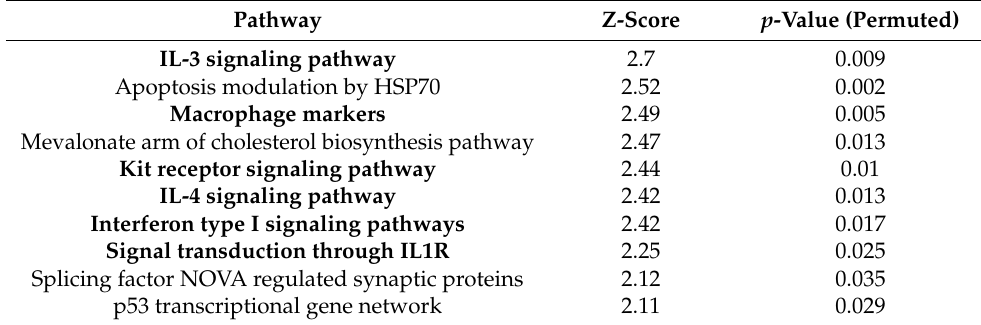
Supplementary Table S2. Cut-off values, i.e., adjusted p -values, for DEG selection using moderated t -tests are indicated. No pathway analysis was conducted for RIVM 4 and 5 preparations as the number of DEGs was too low, even when applying the less stringent adjusted p -value < 0.2. Different pathways are highlighted related to immune response and cell cycle control. For the Bio-Alcamid ® filler extract, the highest scoring pathways were related to immune responses such as macrophage markers and cytokine signaling. For both RIVM preparations and the Perfectha ® filler extracts, the cell cycle pathways were altered. Most genes in the cell cycle pathway are down-regulated (Figures 3 and 4) which is indicative of cell cycle arrest. Additionally, for the Bio-Alcamid ® filler, most of these cell cycle genes are down-regulated (Figure 3), despite the fact that the cell cycle-related pathways are not significantly altered. A full overview of the expression of the genes in the cell cycle pathway shown in Figures 3 and 4 is available as Supplementary Table S3. Table 4. Top 10 significant pathways for M0 macrophages derived from THP-1 cells exposed to Bio-Alcamid ® extract. DEGs selected by moderated t -test with adjusted p -value < 0.05 were used for pathway analysis in PathVisio. Pathways related to immune and inflammatory responses are shown in bold.